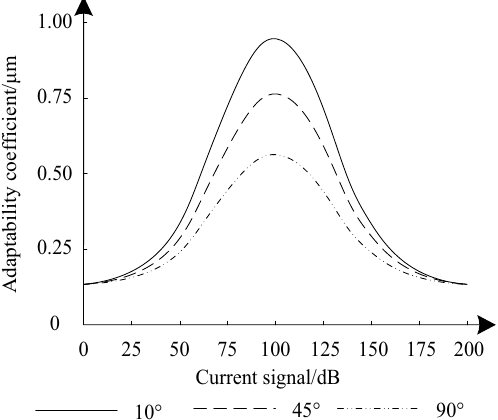
Figure 5. Simulation results of adaptability coefficient.